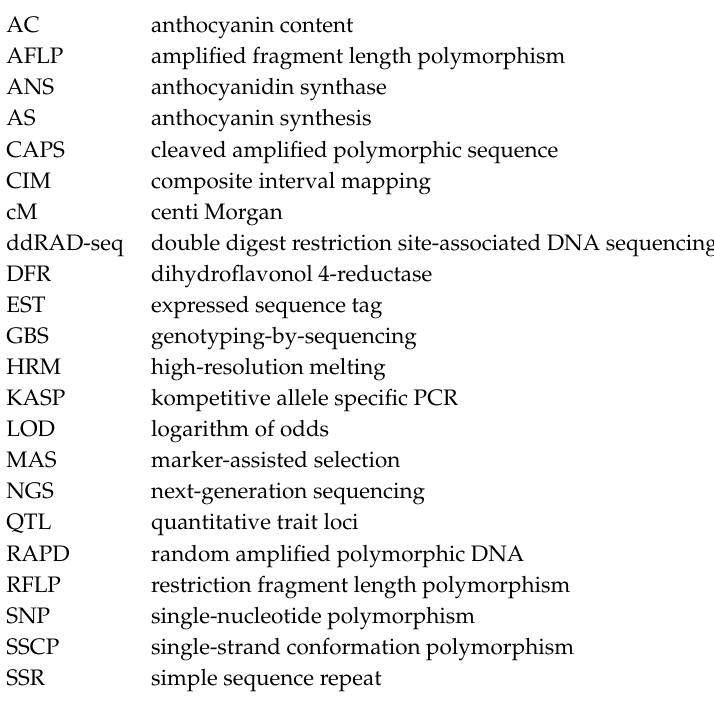
Table S1: The SNP matrix generated by GBS analysis, Table S2: Statistics for GBS-based SNP and HRM markers mapped in this study, Table S3: Cosegregation of the SNP marker (T25488.1_1462) with bulb color in an F 2 population of SP3B ×